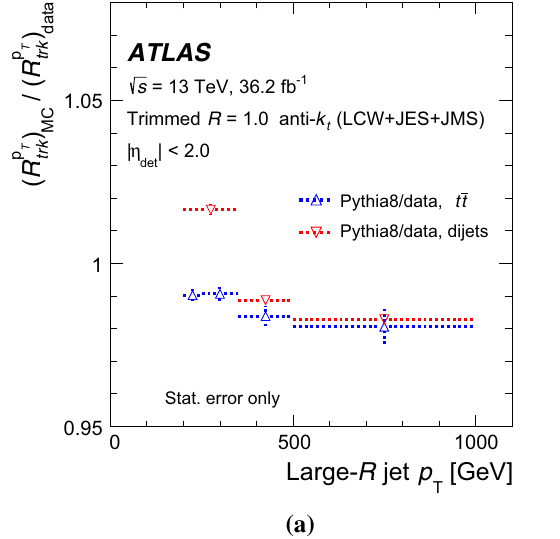
Fig. 18 The simulation/data ratio of R trk for a large- R jet p T and b calorimeter mass as a function of the large- R jet transverse momentum p T . Two sets of results are derived from a dijet sample, dominated by light-quark and gluon jets, and a t ¯ t sample, where the large- R jets con- tain a boosted W boson or top quark. The large- R jet p T is corrected using the simulation calibration, η -intercalibration, and a combination